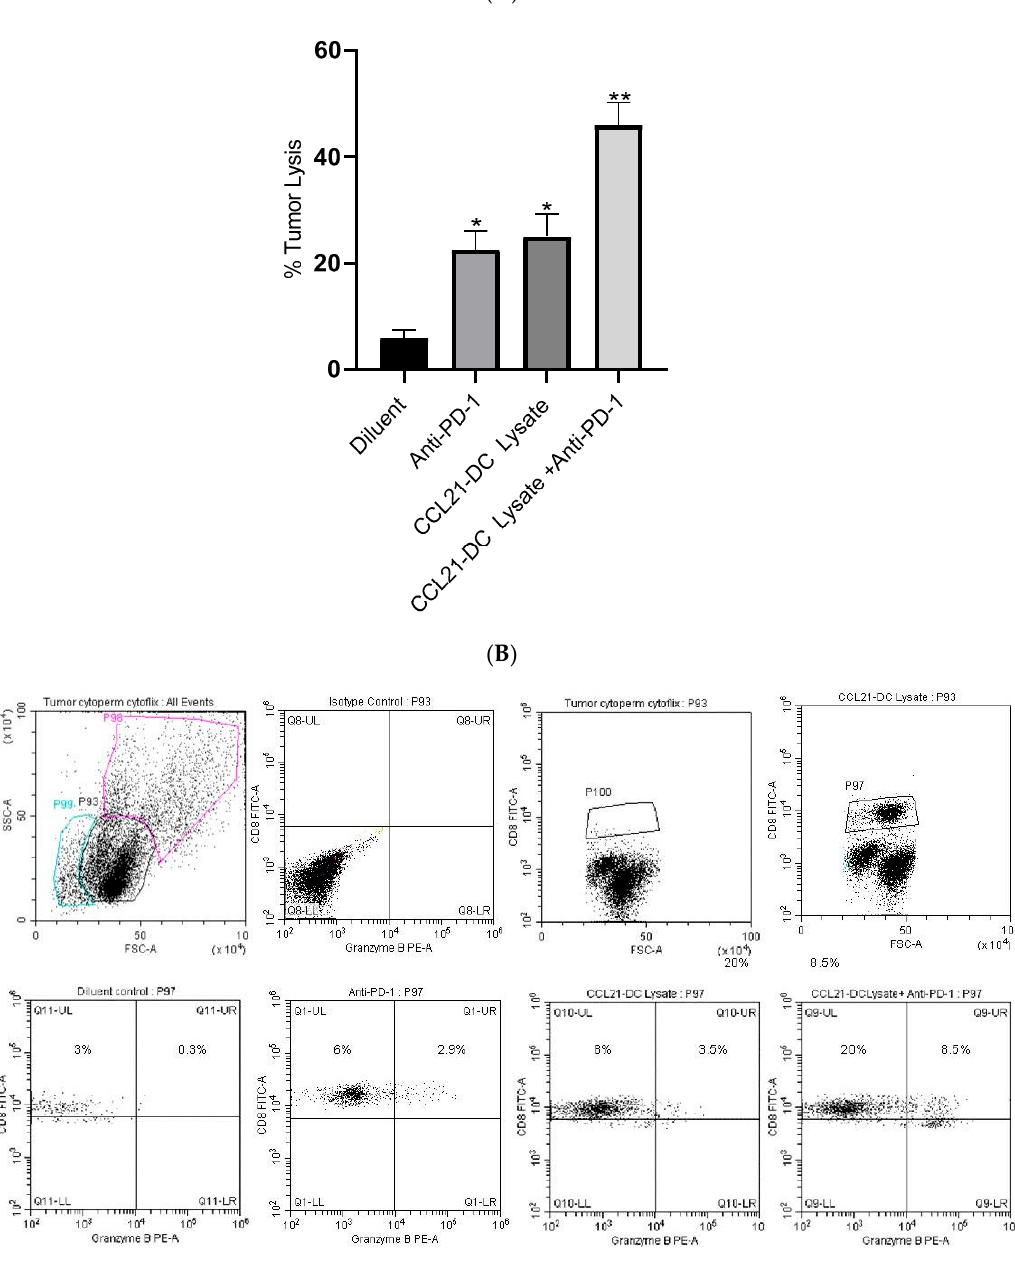
Figure 2. Tumor-infiltrating T cells (TILs) were incubated with K-RasG12Dp53null tumor cells at ratio of 5:1 overnight followed by addition of almar blue for 4 h. TILs from mice treated with combined therapy were most e ff ective at lysing K-RasG12Dp53null tumor cells; ** p < 0.01 in comparison to diluent control, * p < 0.05 compared to monotherapy. Results are representative of an independent experiment ( A ). The experiment was repeated twice ( n = 4 mice / group). Flow cytometric analyses of single-cell suspensions of the tumor microenvironment (TME) following therapy showed enhancement of CD8 T cells expressing granzyme B ( p < 0.05) compared to monotherapy. P98 is dumped cell population, P99 is dead cell population and P100 is CD8 T cell population. Results are representative of an independent experiment. The experiment was repeated twice ( n = 4 mice / group) ( B